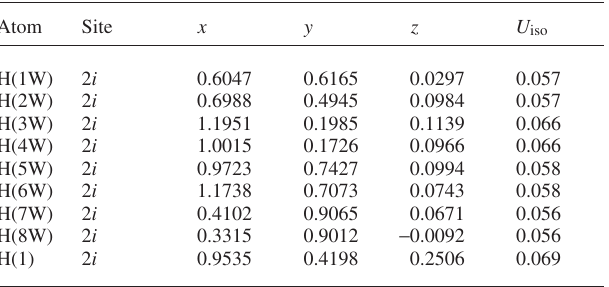
Table 2. Atomic coordinates and displacement parameters (in Å 2 ) . Table 2. Continued